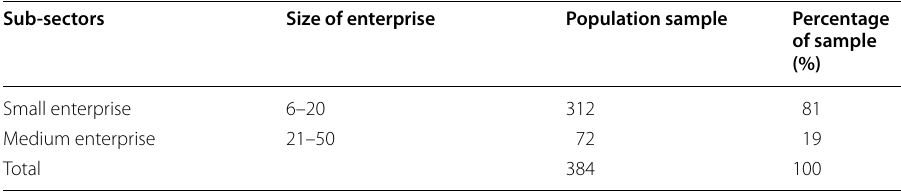
Source: Researcher’s 2021